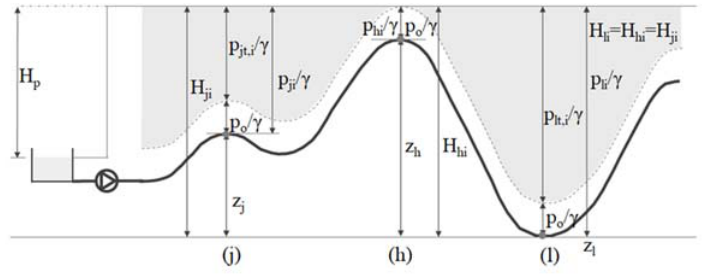
Figure 1. Topographic energy concept in an ideal system, from Cabrera et al. [16].